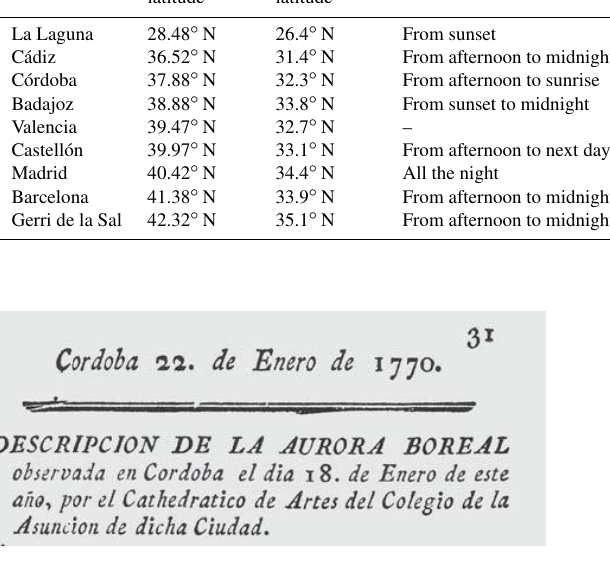
Table 1. Summary of the descriptions made by the Spanish observers for the auroral display on 18 January 1770. Place